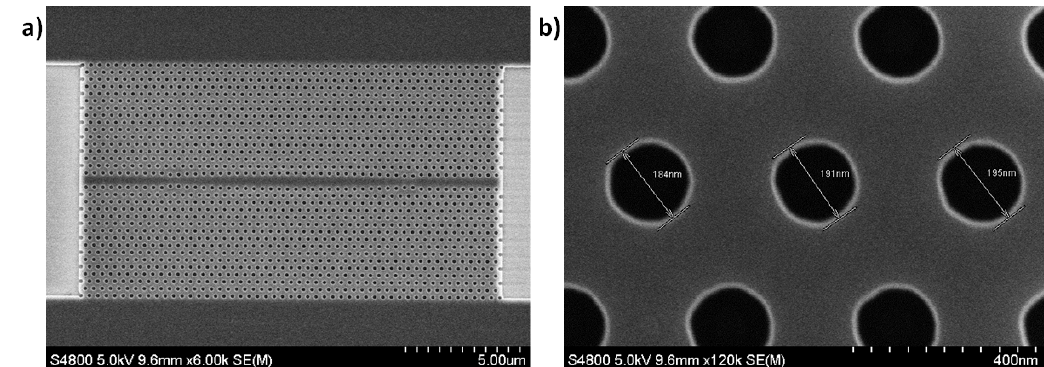
Figure 1. ( a ) Scanning electron microscope (SEM) image of the abricated photonic crystal (PhC) cavity. Length of the PhC cavity is approximately 10µm. ( b ) Close up of the holes in the PhC cavity. Hole diameter is measured to be 190 ±